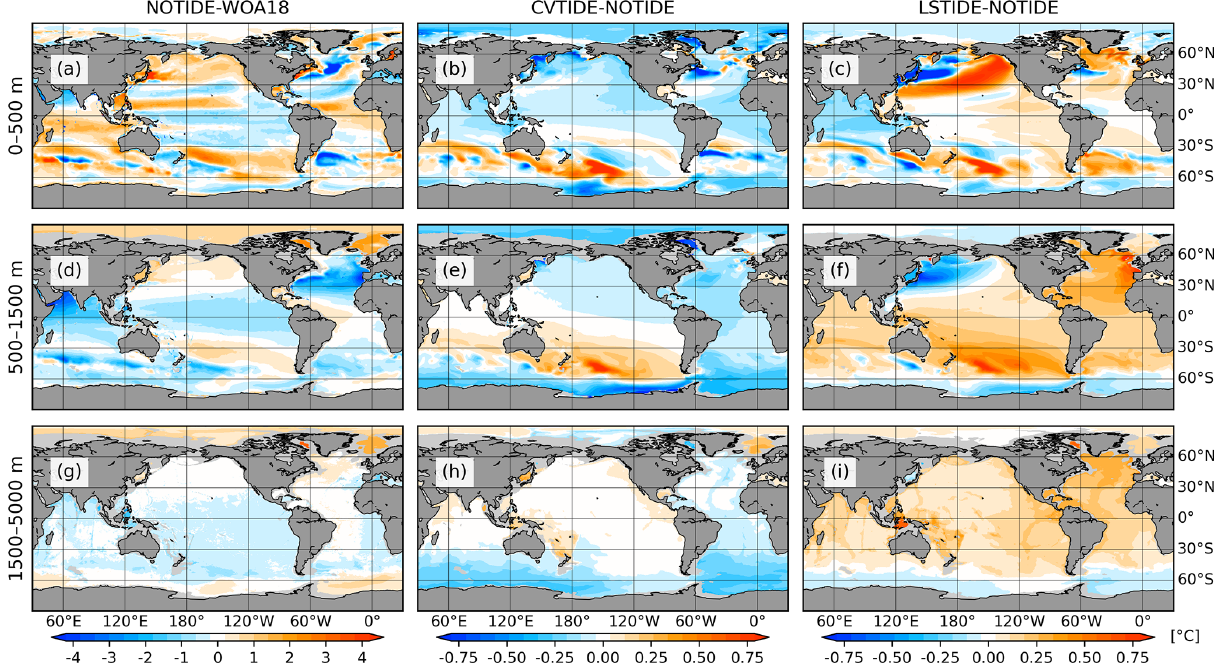
Figure 1. Depth-averaged temperature biases between the model results and WOA18 in the upper (0–500m), intermediate (500–1500m) and deep (1500–5000m) ocean. Panels (a) , (d) and (g) show the biases between NOTIDE and WOA18, and the other panels show the differences between the sensitivity runs and the control run. Opposite colours in panel (a) and panel (b) / (c) indicates that CVTIDE/LSTIDE reduces temperature biases in NOTIDE and so on.